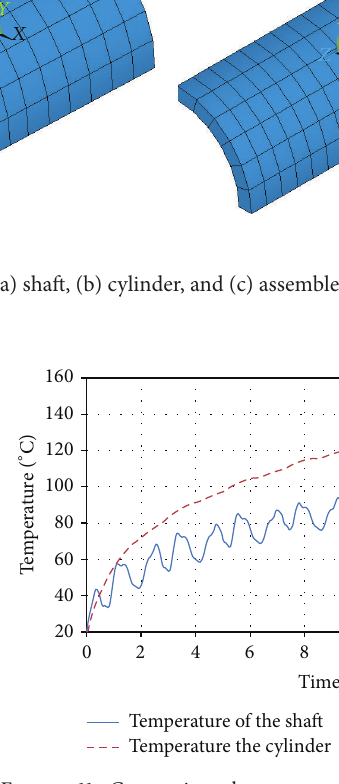
Figure 11: Comparison between temperatures of the shaft and cylinder for original CFD (case